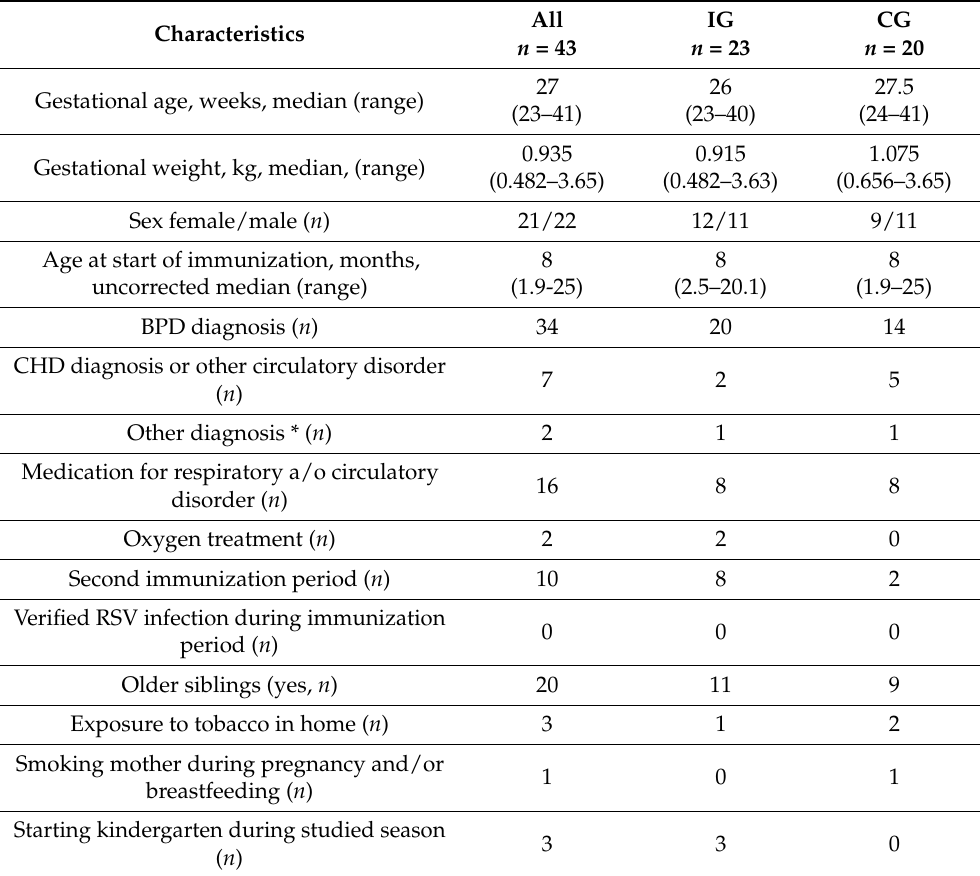
Table 1. Characteristics of